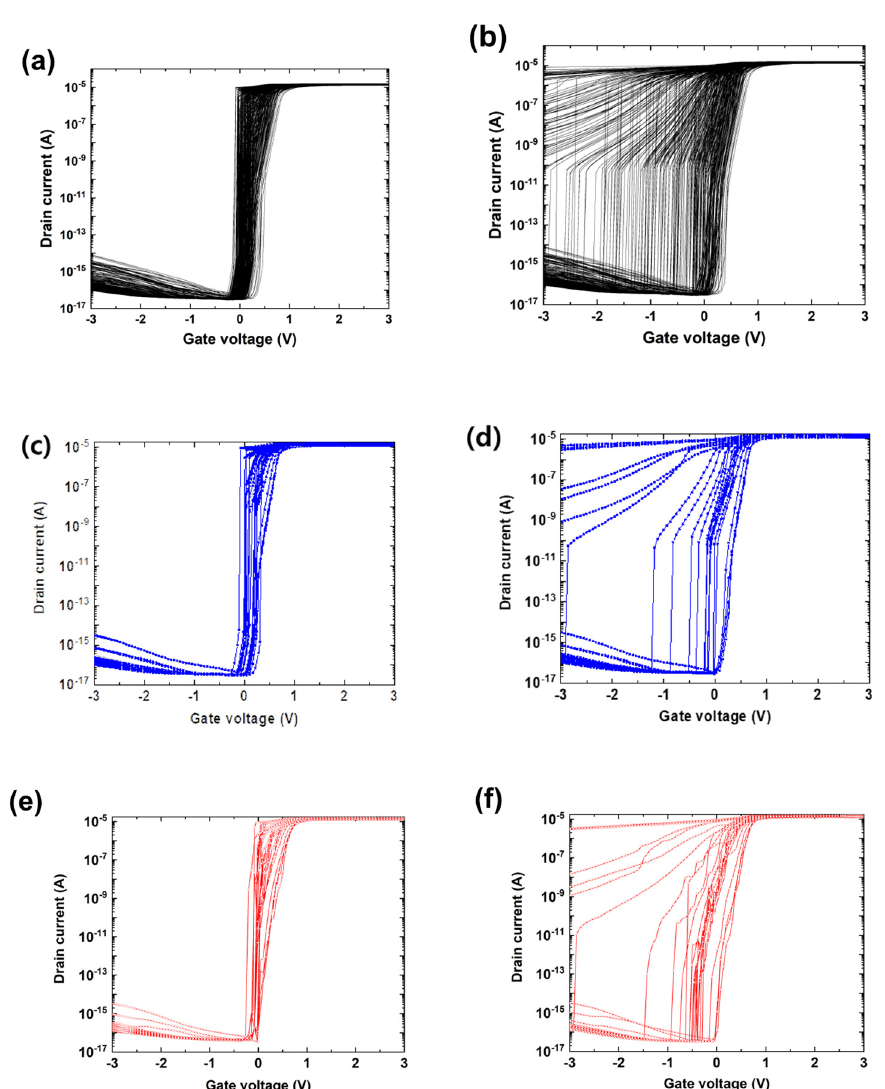
Figure 3. Training dataset with 400 I DS -V GS transfer curves ( a , b ) and the validation dataset with 25 I DS -V GS transfer curves ( c – f ). ( a ) I DS -V GS transfer curves for a forward gate voltage sweep from − 3.0 to 3.0 V. ( b ) I DS -V GS transfer curve in a reverse gate voltage sweep from 3.0 to − 3.0 V. ( c ) Forward-sweep I DS -V GS transfer curves simulated using the TCAD simulator. ( d ) Reverse-sweep I DS -V GS transfer curves predicted using our TCAD-ML algorithm. ( e ) Forward-sweep I DS -V GS transfer curves simulated using the TCAD simulator. ( f ) Reverse-sweep I DS -V GS transfer curves predicted using our TCAD-ML algorithm.